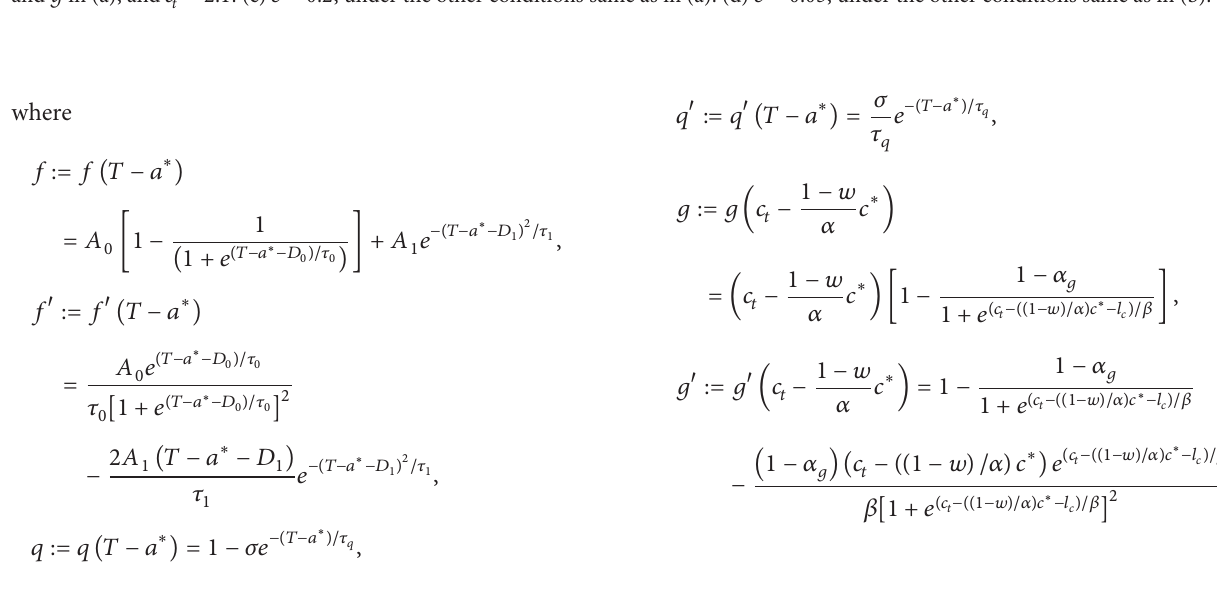
Figure 1: Bifurcation diagrams of system (11) with respect to peak calcium. (a) Peak calcium 𝑐 𝑝 versus total calcium 𝑐 𝑡 , 𝜖 = 0 , with 𝑔(𝑥) = 𝑥[1 − (1 − 0.05)/(1 + 𝑒 (𝑥−0.9)/0.06 )] , 𝑤 = 0.6 , and 𝛼 = 2 . (b) Peak calcium 𝑐 𝑝 versus the proportionality parameter 𝑤, 𝜖 = 0 , with the same 𝛼 and 𝑔 in (a), and 𝑐 𝑡 = 2.1 . (c) 𝜖 = 0.2 , under the other conditions same as in (a). (d) 𝜖 = 0.05 , under the other conditions same as in